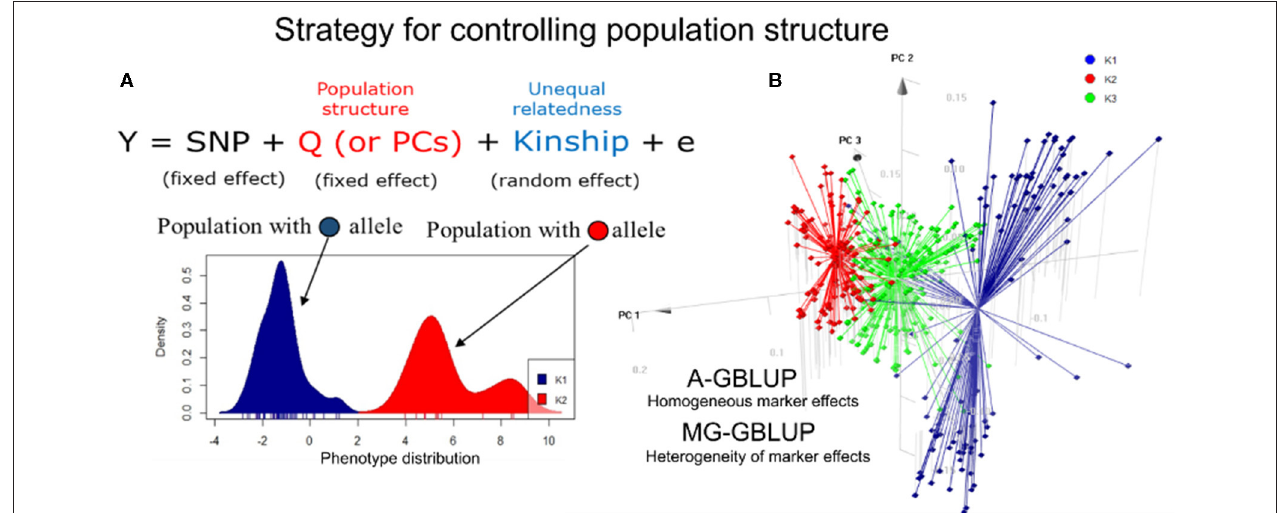
FIGURE 1 | Approaches to control the maize population structure. (A) A mixed linear model accounts for the covariates of population structure (fixed effect) and the genomic relationship matrix (kinship). An example of an allele-specific the population is shown in the graph. (B) 3D graph for the first three major components (PCs) using 452 simple tropical maize hybrids. Two stratification methods for the prediction of hybrids are shown in the panel. The first is a homogeneous group approach (A-GBLUP), which assumes constant marker effects between groups. The second is a multivariate approach (MG-GBLUP) that uses data from several groups and considers heterogeneity, with population-specific marker effects that can be correlated between